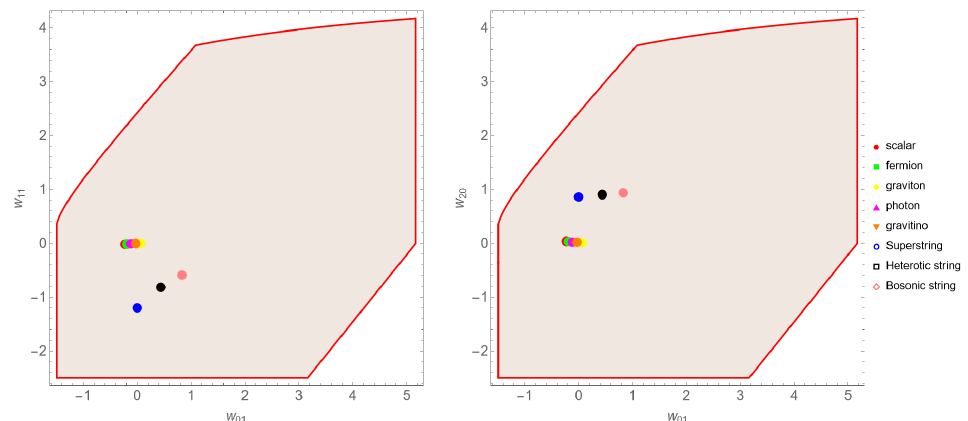
) vs w , w space with scalar, fermion, 11 02 01